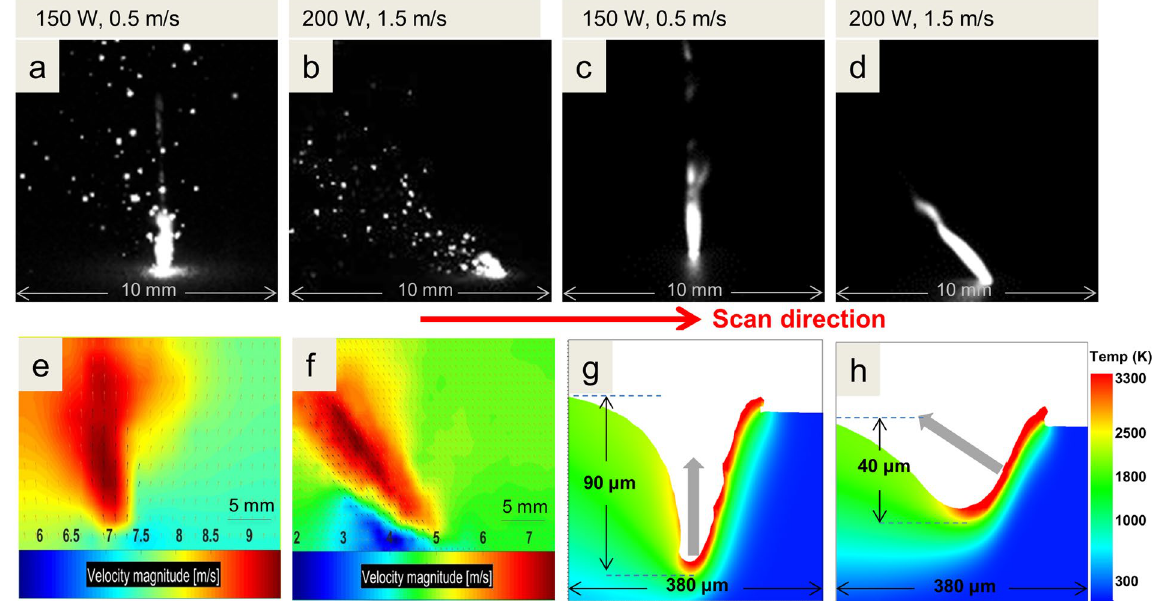
Figure 1. Spatter ejection associated with a SS316L powder layer ( a , b ) and for a SS316L plate ( c , d ) for two parameter cases: 150 W, 0.5 m/s and 200 W, 1.5 m/s. The camera frame rate was 100 kfps with an exposure time of 8 μ s. Laser scanning is performed from left to right. Both cases are in an Ar environment. ( e , f ) Particle Image Velocimetry (PIV) was used to quantitatively measure projected velocities. Average velocities of > 9 m/s are observed at the center of the plume for the 150 W, 0.5 m/s case and > 7 m/s for the 200 W, 1.5 m/s case. Black arrows show actual particle path data and orange arrows are interpolated data. ( g , h ) Simulations showing regions above boiling in the melt pool depression for a bare plate. The arrows indicate the expected direction of the vapor